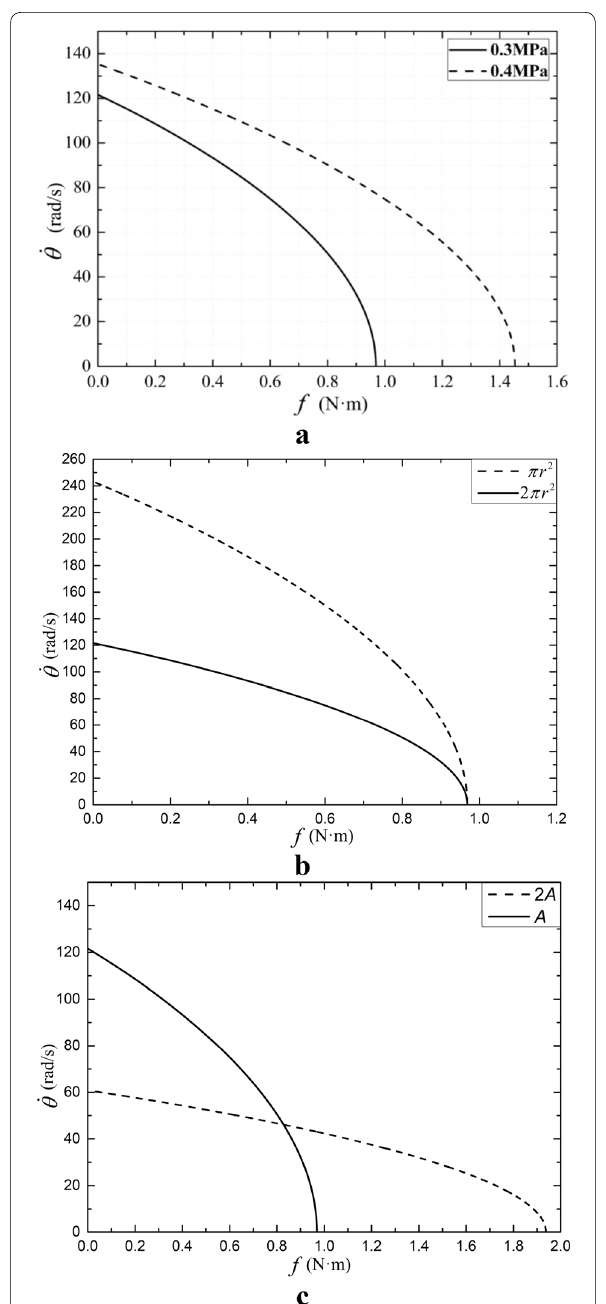
Figure 5 Output characteristic curve of the valve-controlled cylinder: ( a ) Output characteristics of the pressure variation, ( b ) Output characteristics of the change in the valve port area, ( c ) Output characteristics of the variation in the effective piston